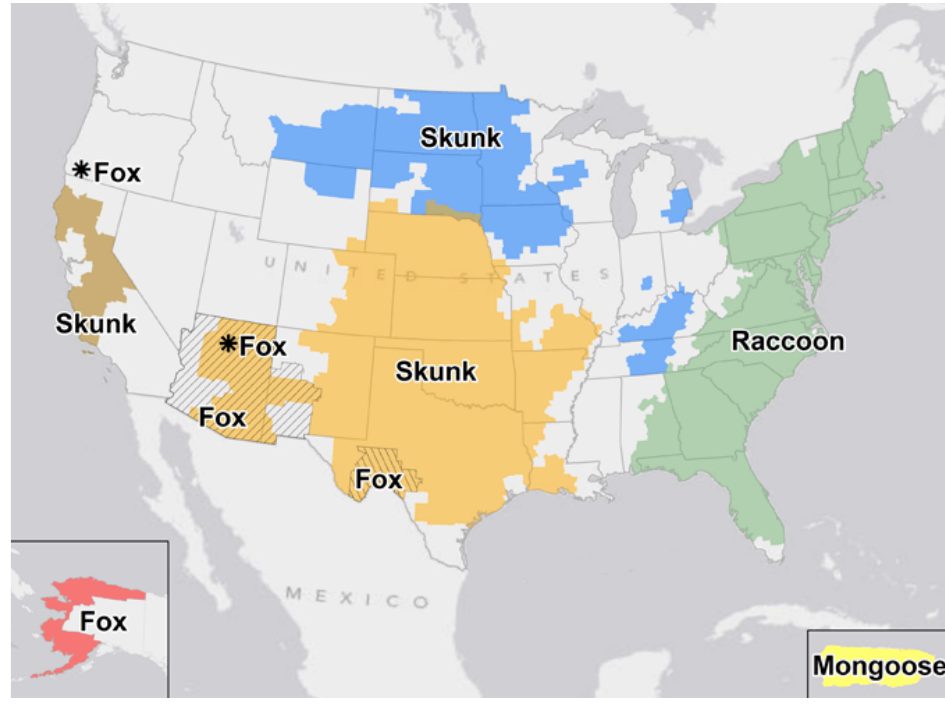
Figure 1. Reservoir species for rabies across the